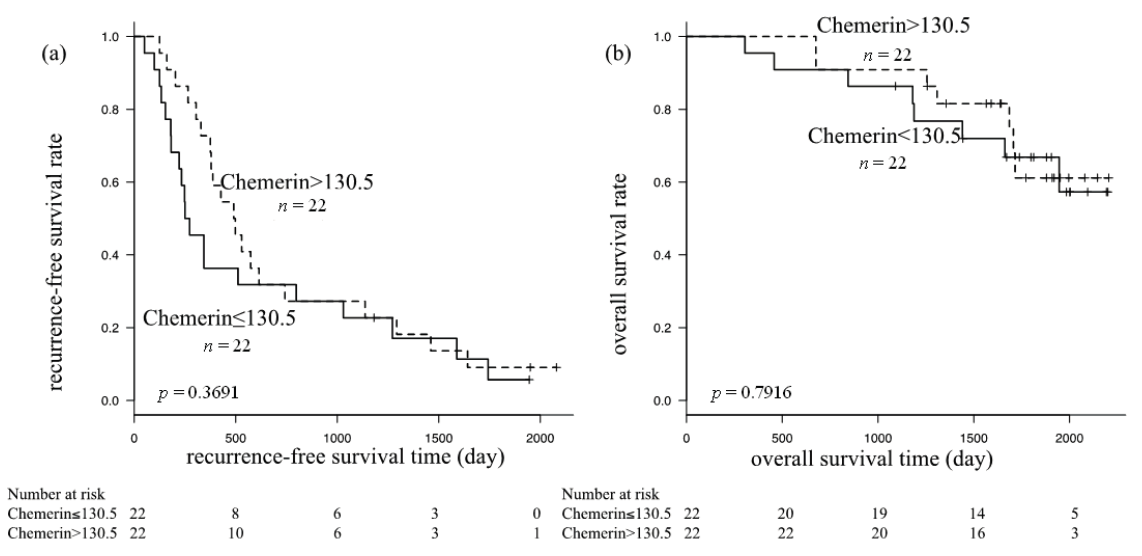
Figure 2. Kaplan-Meier curves for ( a ) recurrence-free survival; and ( b ) overall survival